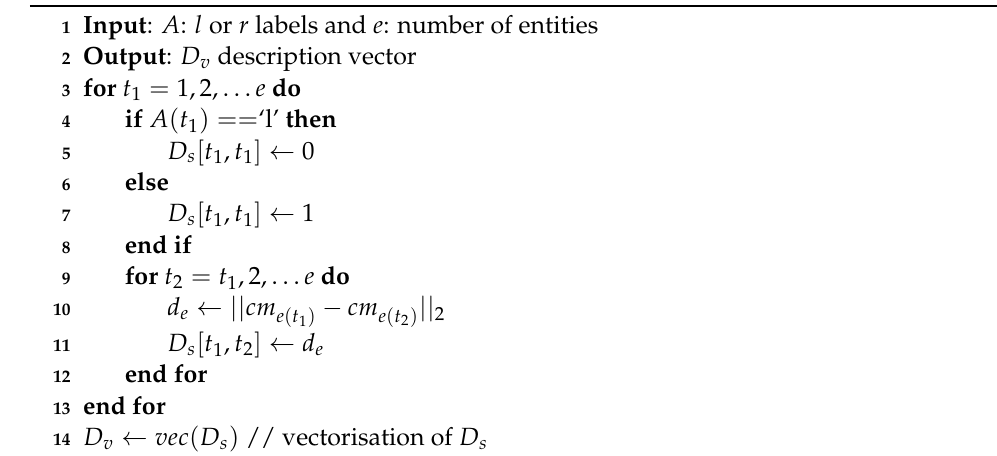
Algorithm 1: Pseudocode algorithm for the creation of the proposed graph- based description